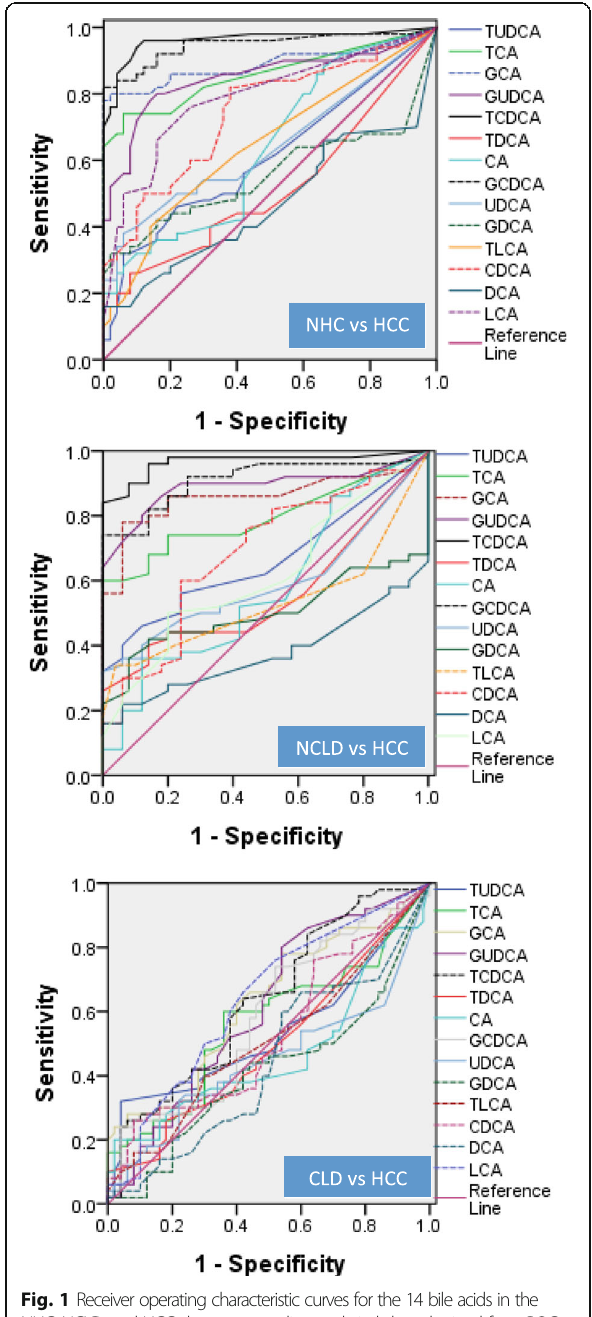
Fig. 1 Receiver operating characteristic curves for the 14 bile acids in the NHC, NCLD, and HCC: the corresponding analytical data obtained from ROC curve analysis including AUC, the cutoff point at the Youden ’ s index, the sensitivity, and the specificity of each bile acid are summarized in Table 3. NHC, normal healthy control; NCLD, noncirrhotic liver disease; CLD, cirrhotic liver diseases; HCC, hepatocellular carcinoma; TUDCA, tauroursodeoxycholic acid; TCA, taurocholic acid; GCA, glycholic acid; GUDCA, glycoursodeoxycholic acid; TCDCA, taurochenodeoxycholic acid; TDCA, taurodeoxycholic acid; CA, cholic acid; GCDCA, glycochenodeoxycholic acid; UDCA, ursodeoxycholic acid; GDCA, glycodeoxycholic acid; TLCA, taurolithocholic acid; CDCA, chenodeoxycholic acid; DCA, deoxycholic acid; LCA, lithocholic